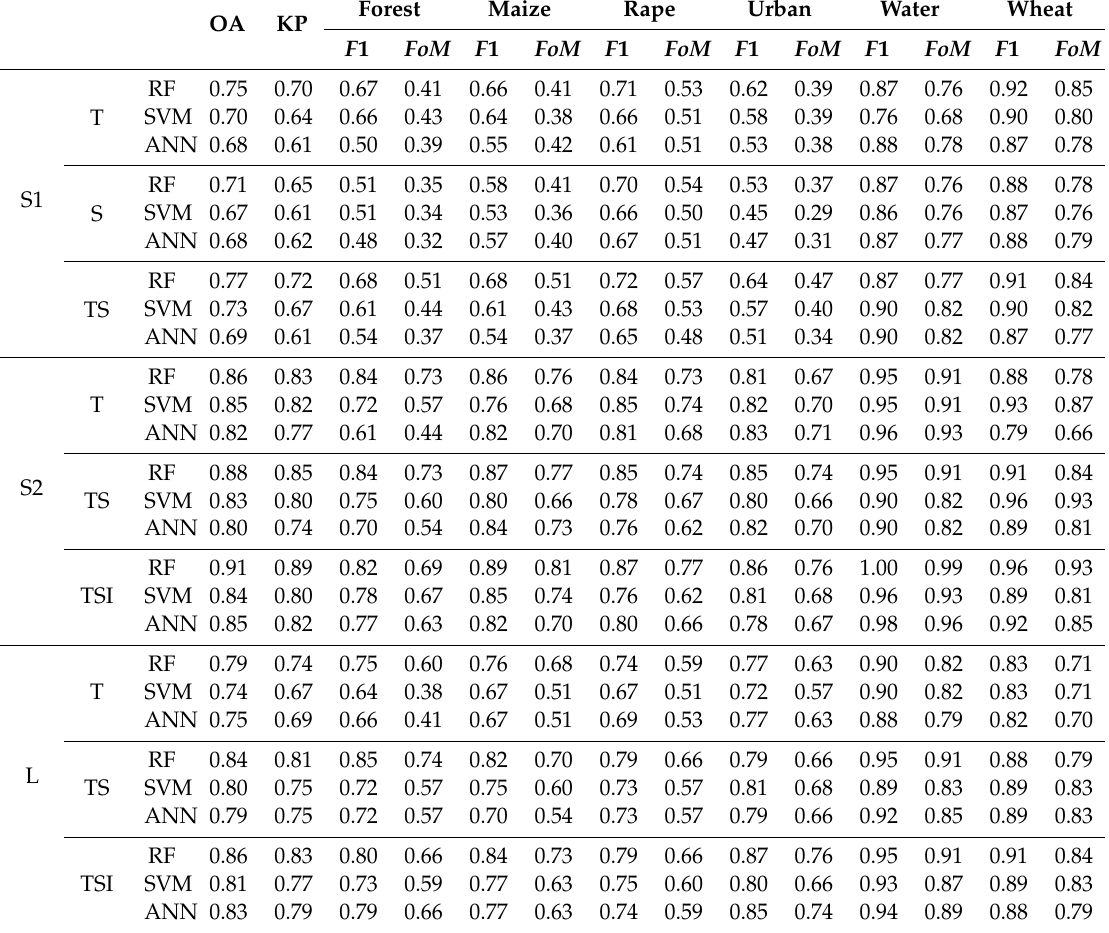
Table 6. The overall accuracy (OA), Kappa coe ffi cient, and F 1 accuracy of di ff erent features with three classifiers from Sentinel-1, Sentinel-2, and Landsat-08 satellite data. RF: Random Forest, SVM: Support Vector Machine, ANN: Artificial Neural Network. Forest Maize Rape Urban Water OA KP